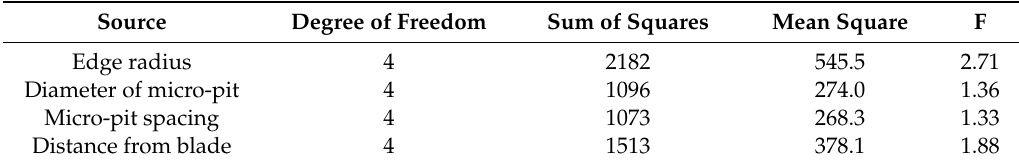
Table 4. Variance analysis of simulation data.